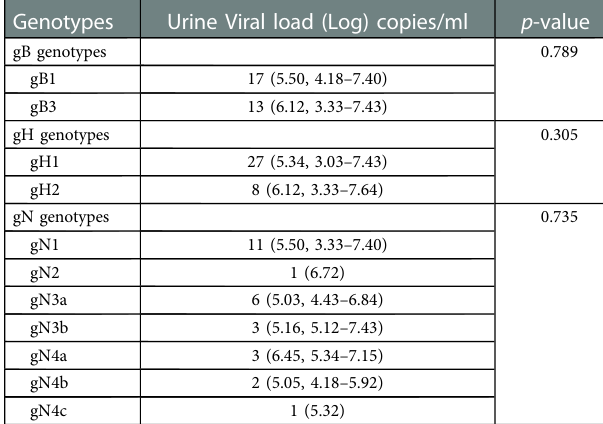
TABLE 4 Comparison of viral loads of gB, gH and gN genotypes in urine samples in infants with symptomatic cCMV infection. Genotypes Urine Viral load (Log)